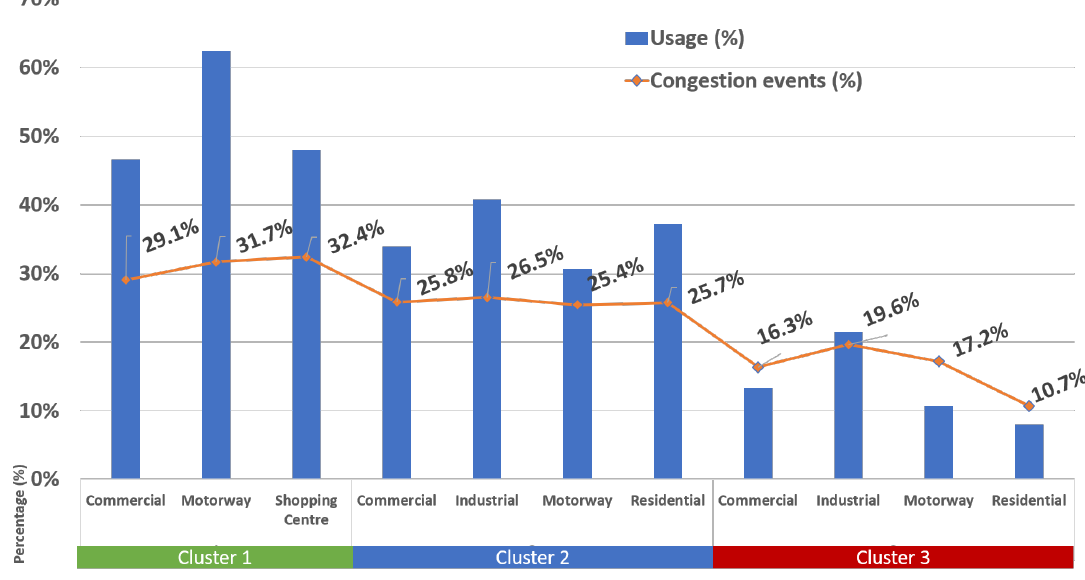
Figure 19. Network infrastructure usage and congestion events in percentage for year 2019 (Jan–Feb).